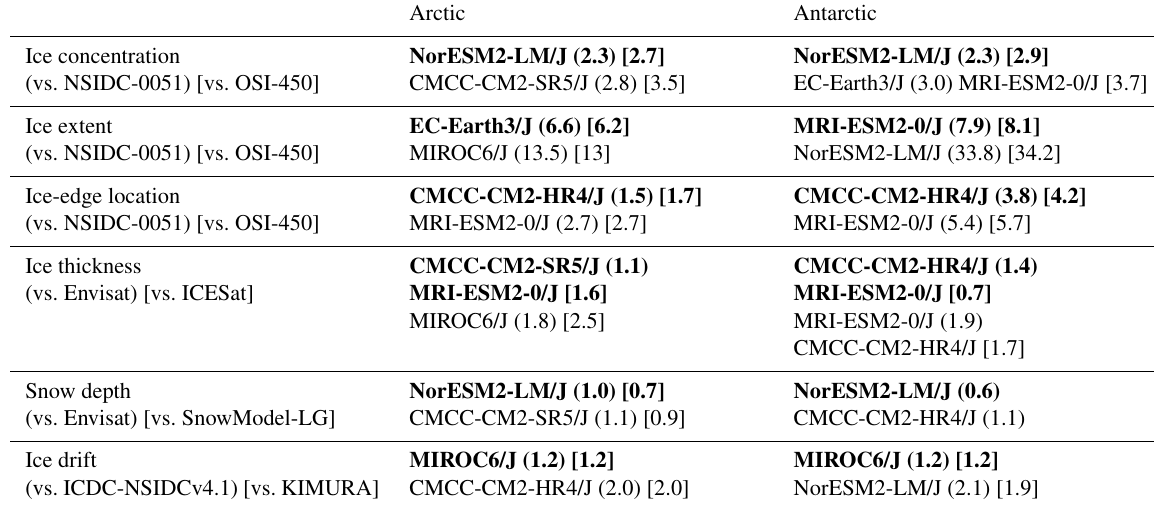
Table 4. The best- (in bold) and worst-performing models for the six evaluated sea ice variables, among the models forced by the JRA55-do the performance metrics in Figs. 2, 5, 7, and 10 (marked as () and []). The values given average the three metrics (mean state, interannual variability, and trend) for ice concentration and ice extent from Figs. 2, 5a and b; the two metrics for the magnitude and vector correlations for ice drift from Fig. 10. The values for the ice-edge location, thickness, and snow depth are the metric of mean state from Figs. 5c and 7. In some cases, such as for the ice thickness evaluation, the best- and worst-performing models are different compared to different sets of